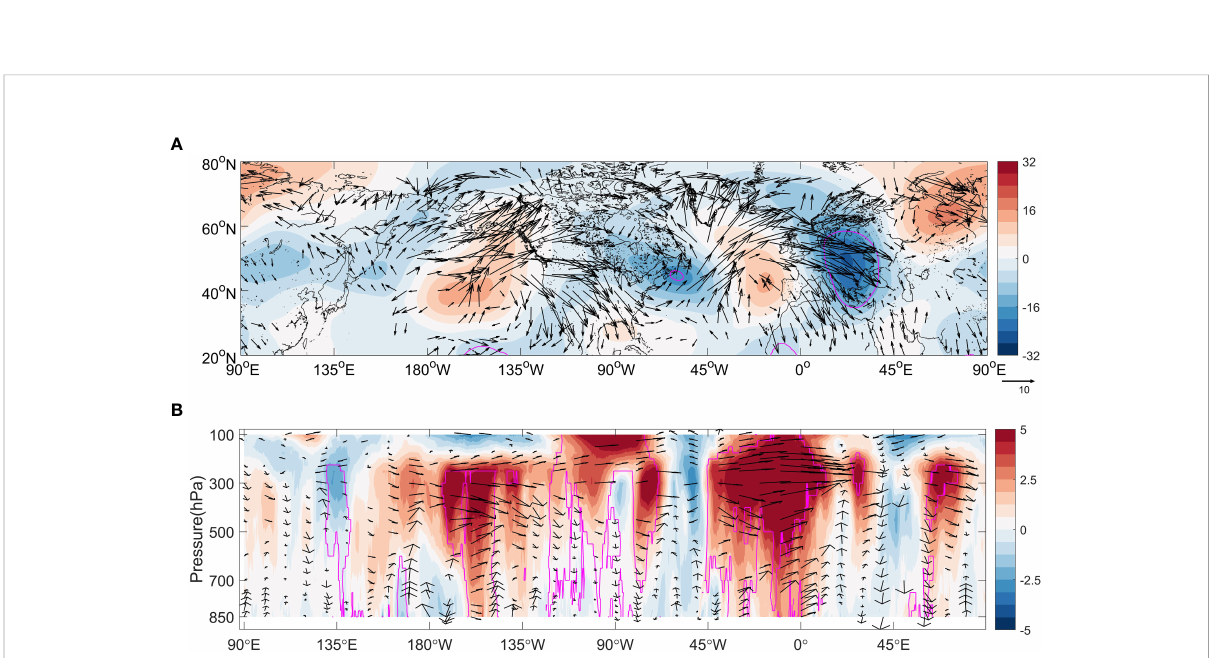
FIGURE 7 The lagged regressions of atmospheric anomaly in DJF onto the KEI 2 months earlier. (A) 300-hPa geopotential height (shading; unit, gpm) and WAF (vectors; unit, m 2 s − 2 ). (B) Zonal component of WAF (shading; unit, m 2 s − 2 ) and WAF (vectors; unit, m 2 s − 2 for horizontal component and − 10 − 2 Pa m s − 2 for vertical component) averaged between 40°N and 60°N. The vectors plotted in the fi gures are signi fi cant at the 90% con fi dence level, with magenta contours passing the 90% con fi dence level. KEI, Kuroshio Extension index; WAF, wave activity fl